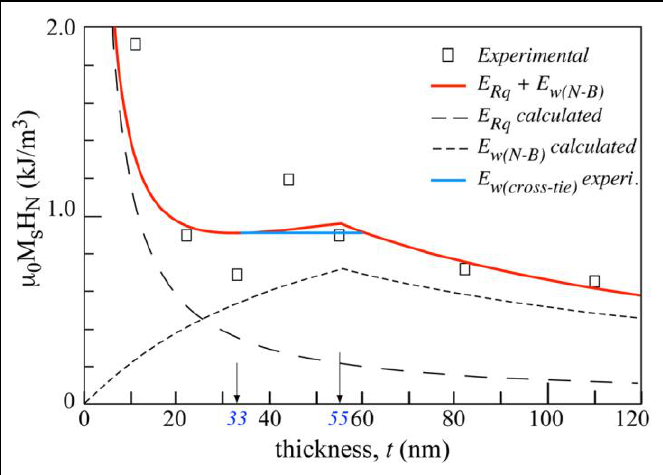
Figure 10. Fit (solid red line) of experimental values (square symbols) of applied magnetic field to nucleate magnetic domain walls using expression of Néel or Bloch wall energy, E w(N-B), plus energy corresponding to magnetostatic interaction of core plus wall tail with surface roughness of sample E Rq . Lower crosstie wall energy E w(crosstie) is illustrated for the interval of sample thickness between 33 nm and 55–60 nm. Parameter values used in the fit are: exchange stiffness constant A = 1.8 × 10 –11 J m – 1 , magnetic anisotropy constant K ≈ 0, magnetization μ 0 M s = 2 T, wall thickness d w = 55 nm, ratio of total length of nucleated magnetic wall to total film surface area L w / S T = 2.0 mm −1 , surface roughness R q = 2 nm, demagnetizing factor N d = 0.2, and tail of charged wall d t = 5.5 μm.